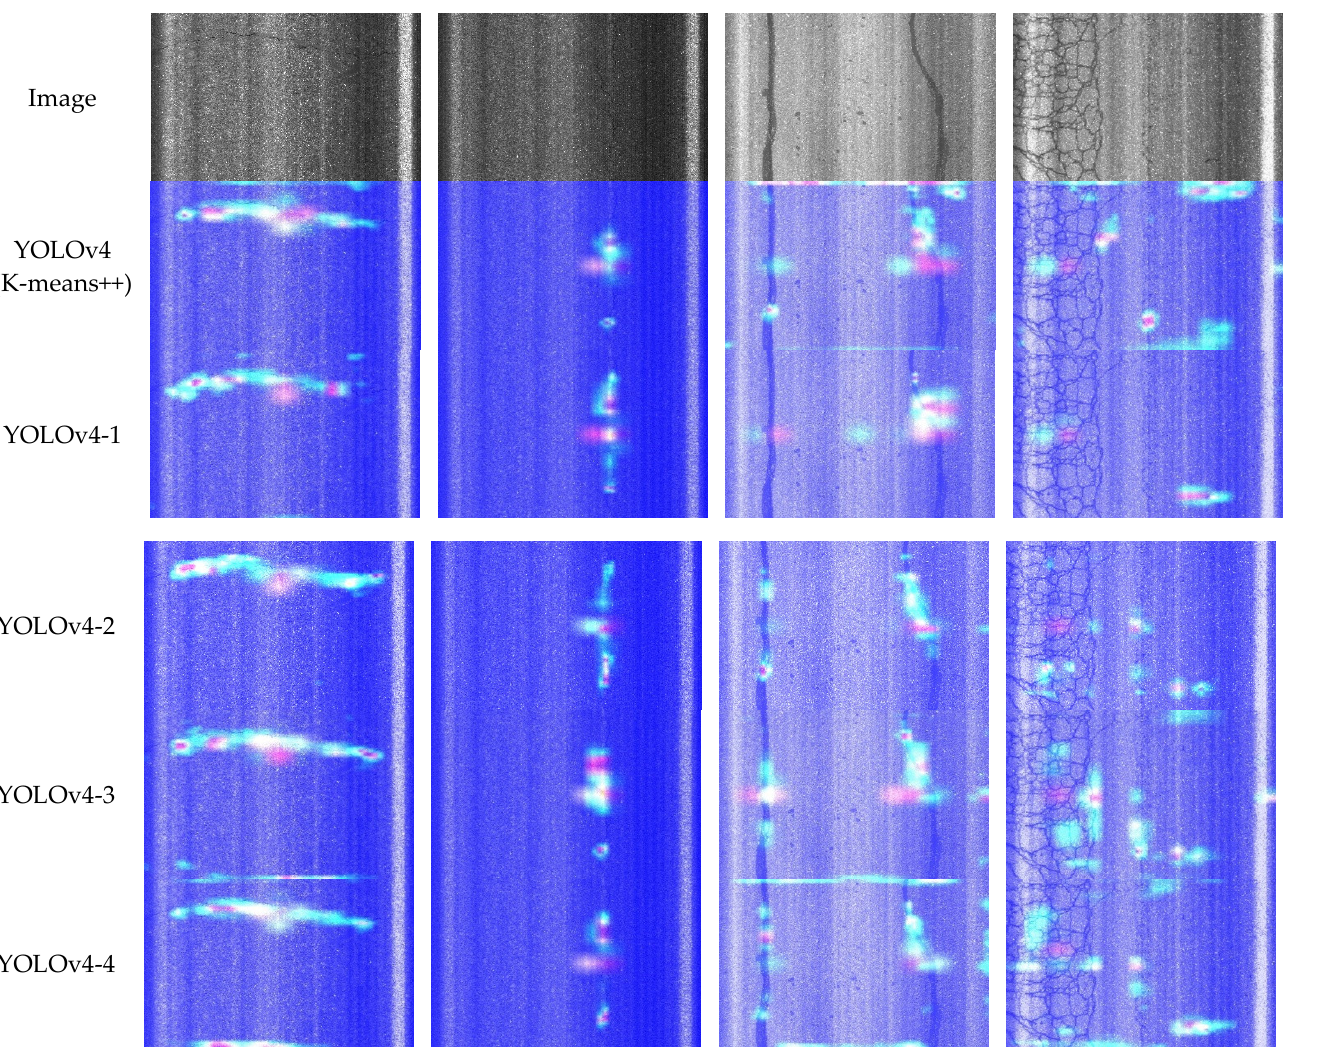
Figure 11. The three output feature layers ( left ); visualized feature maps after superimposition ( right ).